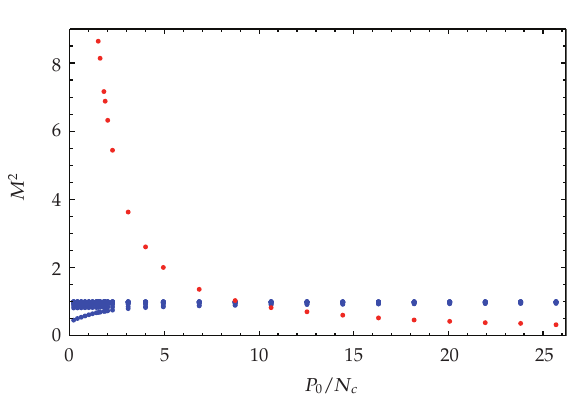
Figure 11: The masses M 2 plotted against P 0 /N c (cid:9) 2 ρ ∗ (cid:3) 57 (cid:4)